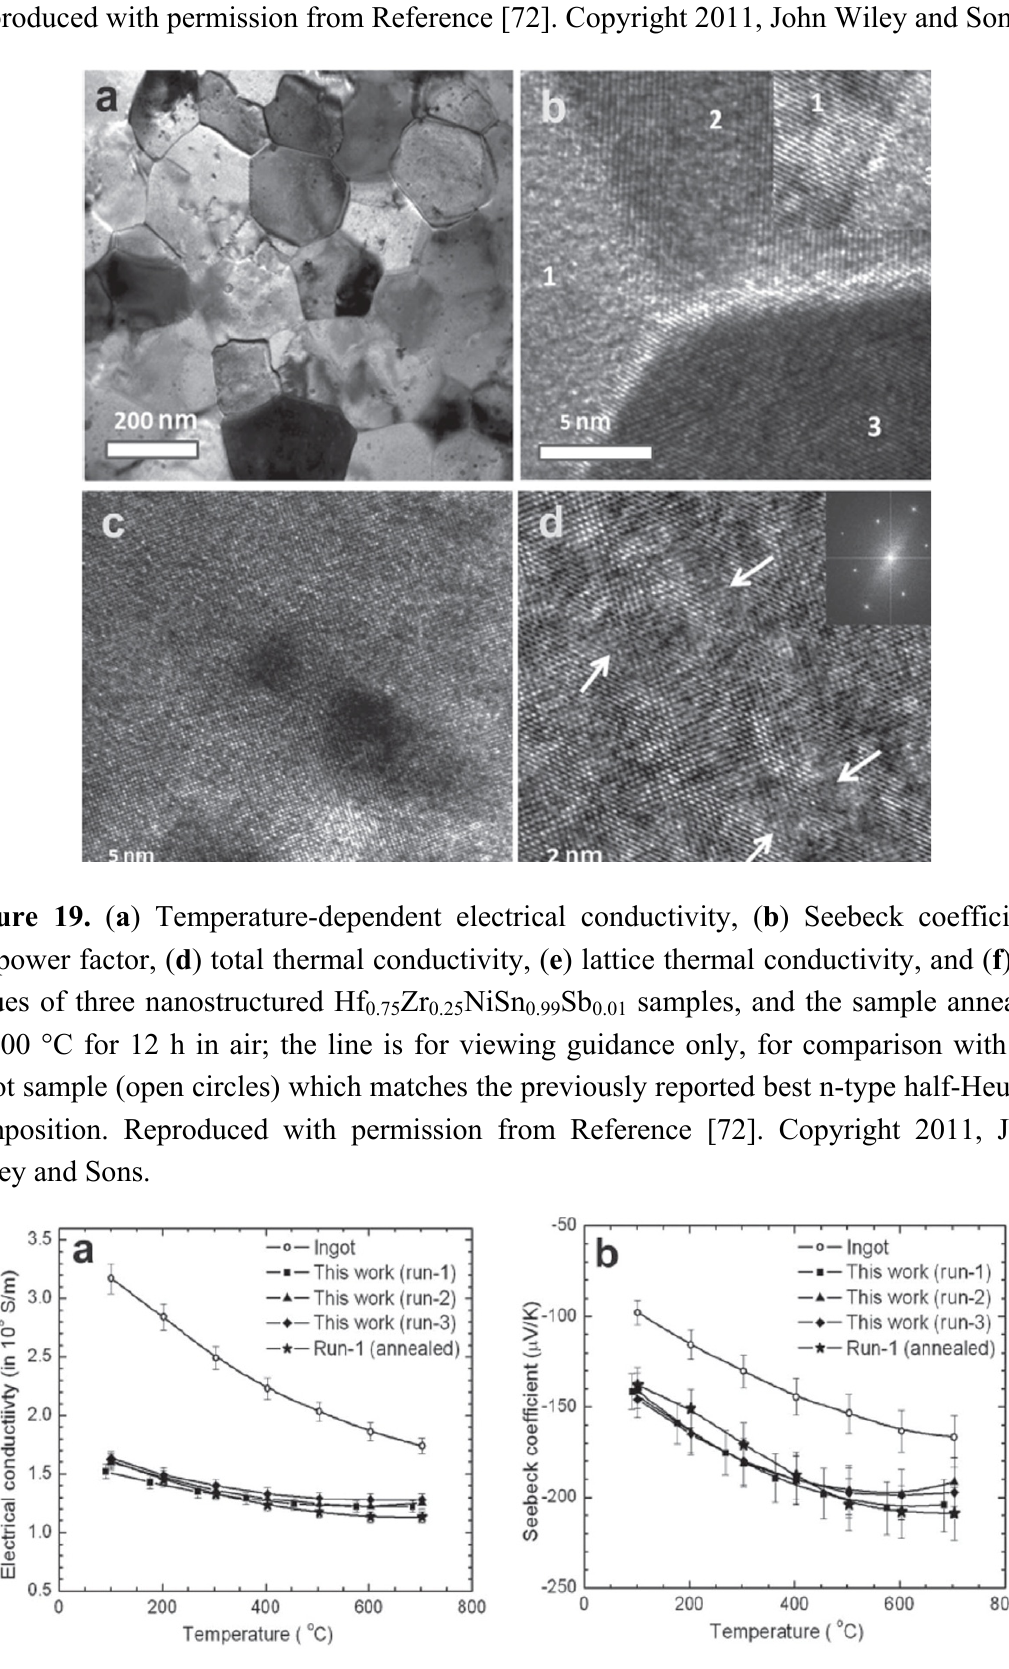
Figure 18. ( a ) Low- and ( b – d ) high-magnification TEM images of a BM-HPed Hf Zr NiSn Sb nanocomposite. The inset in ( b ) shows the crystalline nature of 0.75 0.25 0.99 0.01 grain 1 with a rotation. The inset in ( d ) shows the grains as good crystalline structures. Reproduced with permission from Reference [72]. Copyright 2011, John Wiley and Sons.